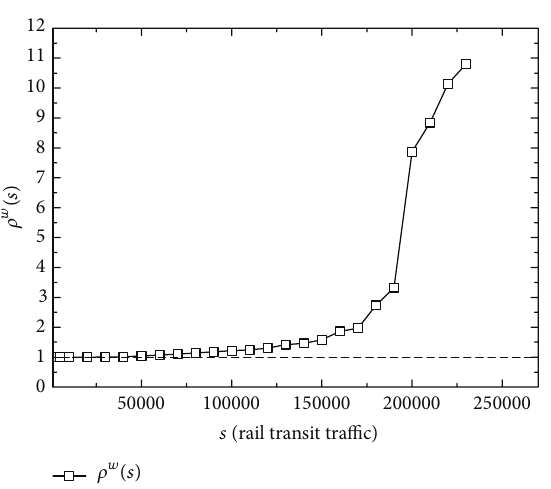
Figure 7: Weighted rich-club effect in the RTS network.